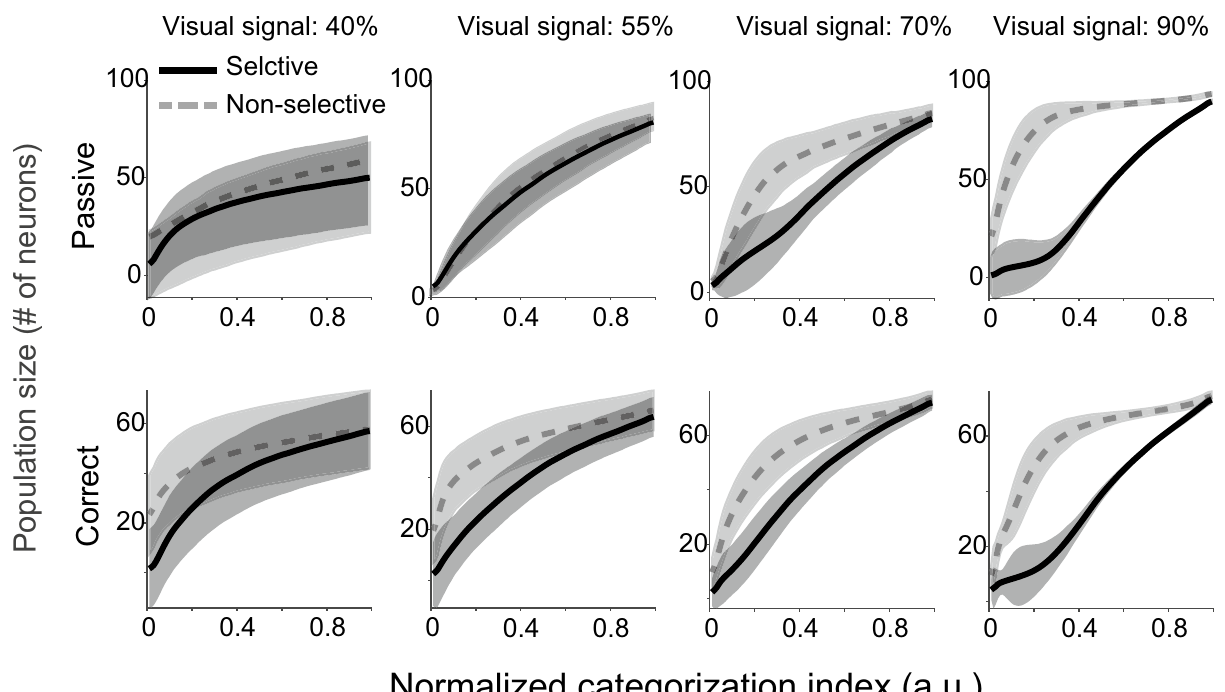
Figure 8. The number of single units as a function of normalized categorization index. The estimated number of units (y-axis) that can explain X% of the ultimate CI (x-axis) is plotted in each condition. Columns show visual signals and the two rows depict passive and correct trails. Shaded areas represent the STD of bootstrap samples.